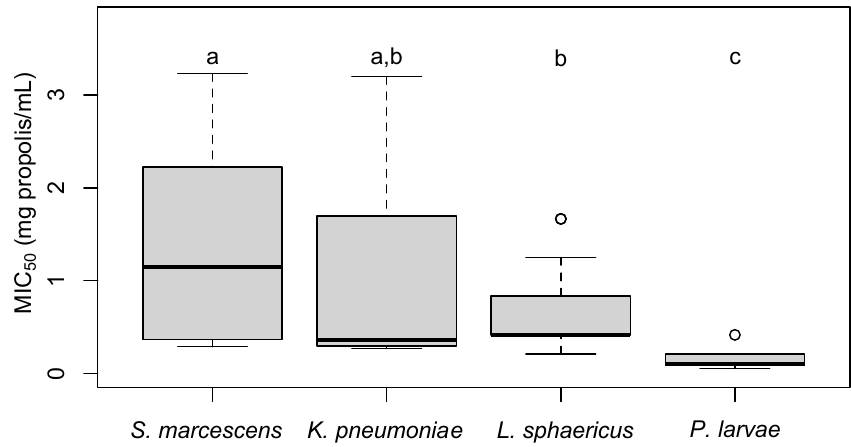
Figure 4. Box plot of MIC 50 values of propolis samples according to pathogen tested. Boxes not sharing the same letter superscript are significantly different from each other ( p < 0.05). This section may be divided by subheadings. It should provide a concise and precise description of the experimental results, their interpretation, as well as the experimental conclusions that can be drawn.